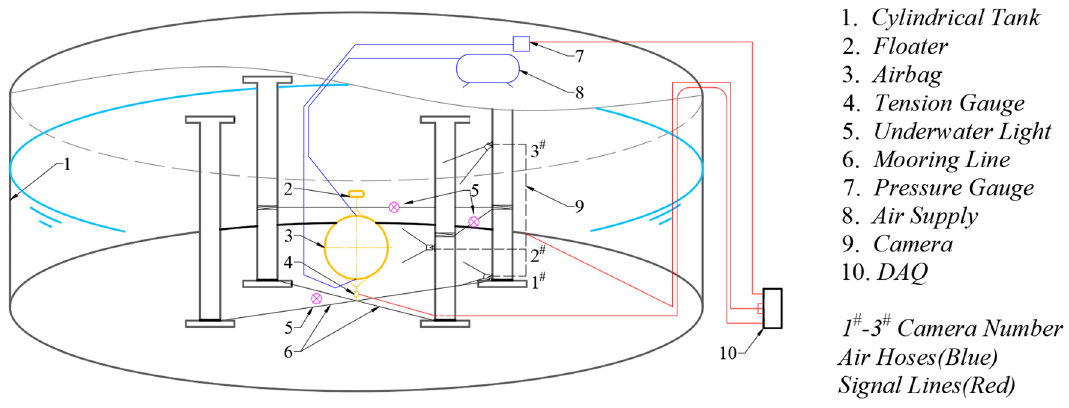
Figure 2. Layout diagram of equipment and instruments for the reservoir test. There were four pillars inside, to which the mooring lines and cables were fixed. They formed a square area of 4.1 m in length as the vertexes, and the airbag was installed at the center of the square area.